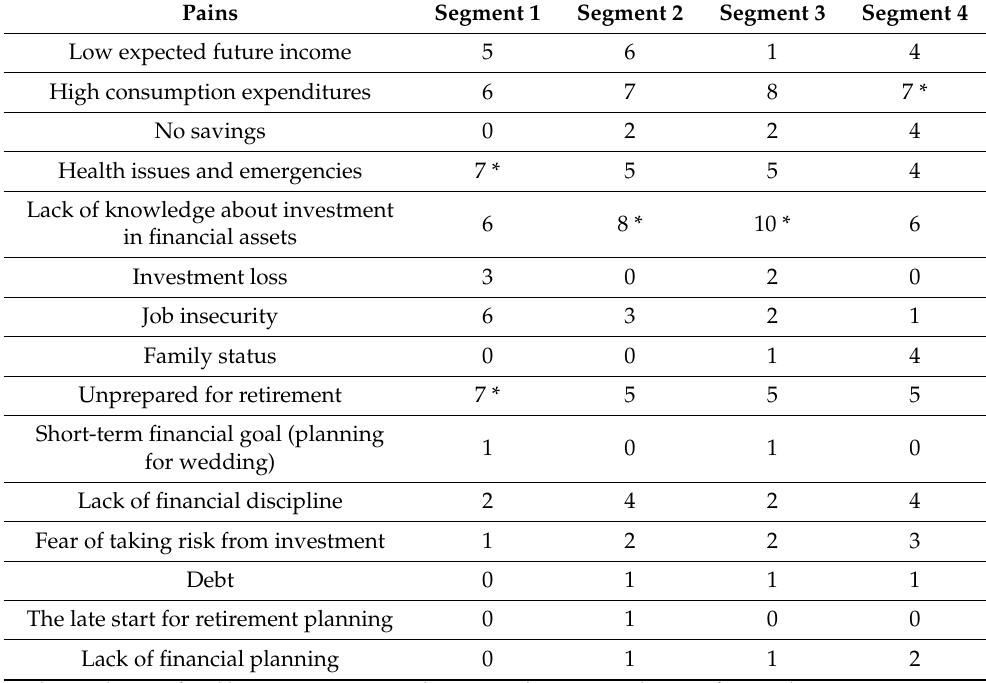
Table 8. Most common pains from interviewees of each